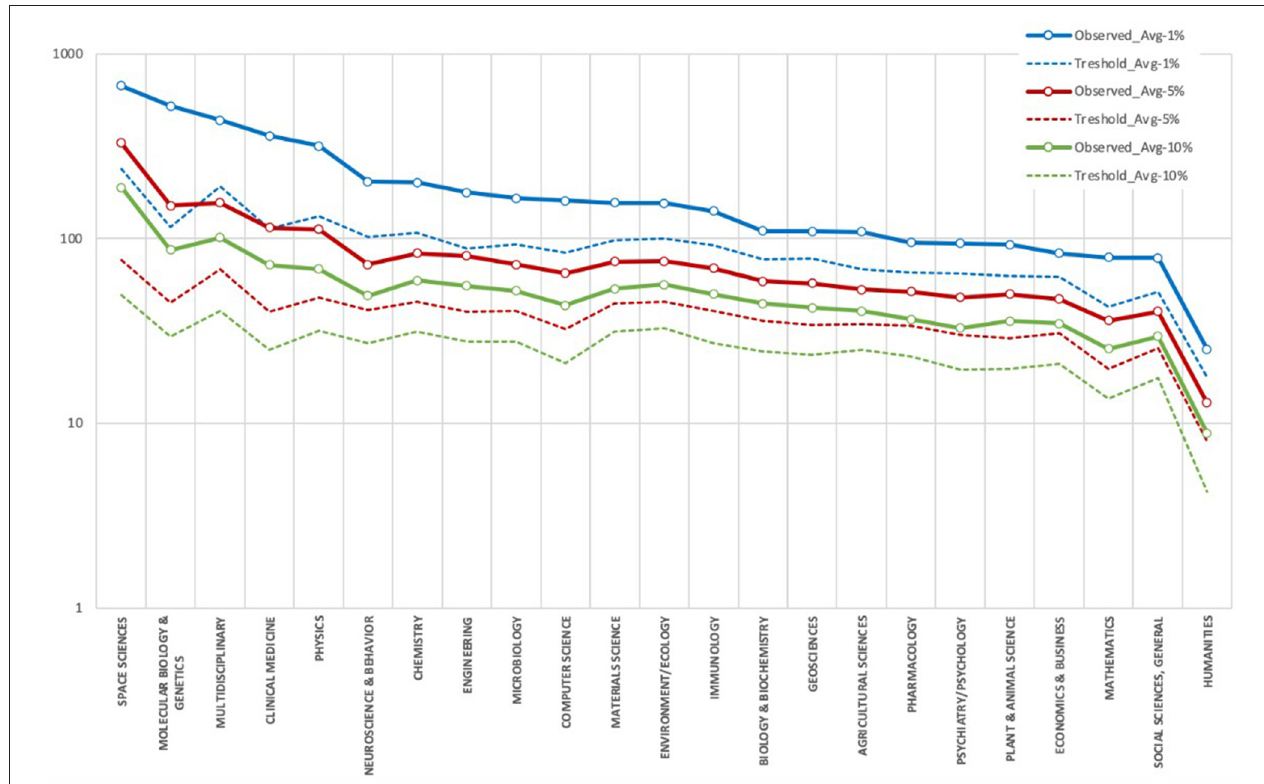
FIGURE 7 | Citation per document by university